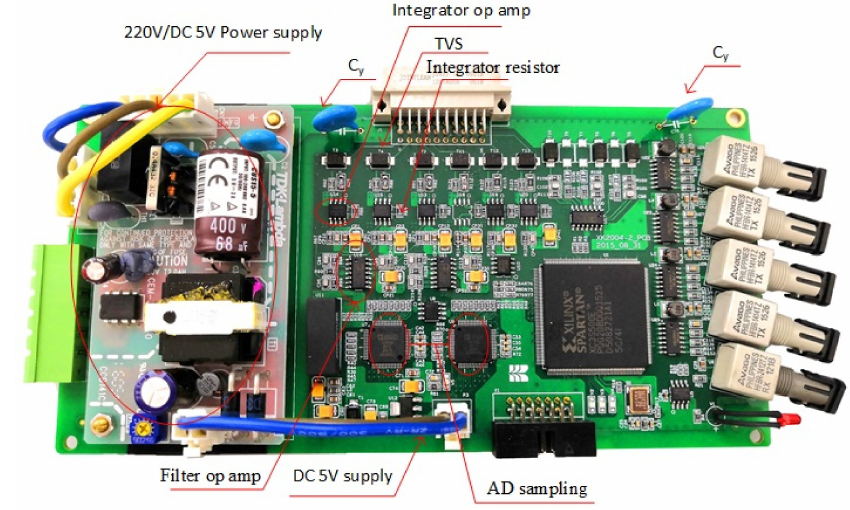
Figure 18. The sampling unit developed in this paper.